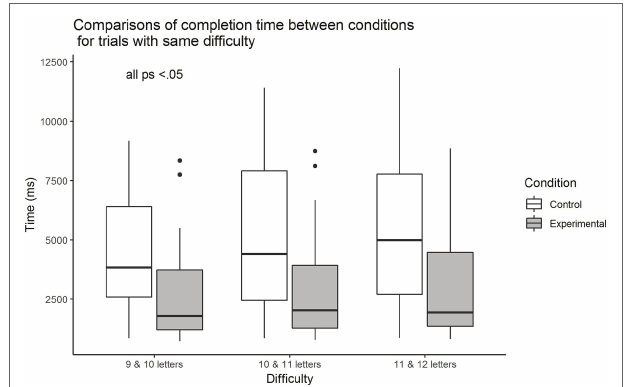
FIGURE 3 | Comparison of mean time spent on each trial between control and experimental groups for three difficulty